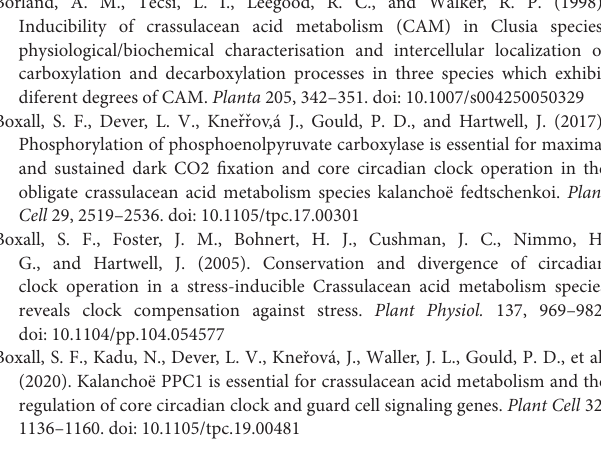
Supplementary Figure 1 | Photograph of the microscope system along with leaf section chambers. Supplementary Figure 2 | Examples of images taken using the microscopy system. Image of stoma taken from intact leaf segments from (A) Kalanchoë fedtschenkoi (B) Vicia faba , and from epidermal peels of (C) Kalanchoë fedtschenkoi and (D) Vicia faba . All scale bars represent 10mm. Supplementary Figure 3 | Changes in titratable acidity of Vicia faba (C 3 ) and Kalanchoë fedschenkoi (CAM) grown in a “light” growth chamber (light period 8:00a.m. to 8:00 p.m.) and in reverse time “dark” cabinet (light period 8:00 p.m. to 8:00a.m.) for local time. All other variables were the same in both chambers: light intensity of 390 µ mol m − 2 s − 1 , the temperature of 18 ◦ C (night) and 25 ◦ C (day), and air humidity of 60%. The dawn moment was 7:30a.m. and dusk was 7:30 p.m. The values are means of three repetitions ( ± SE). Means followed by different letters denote differences among treatments ( P <